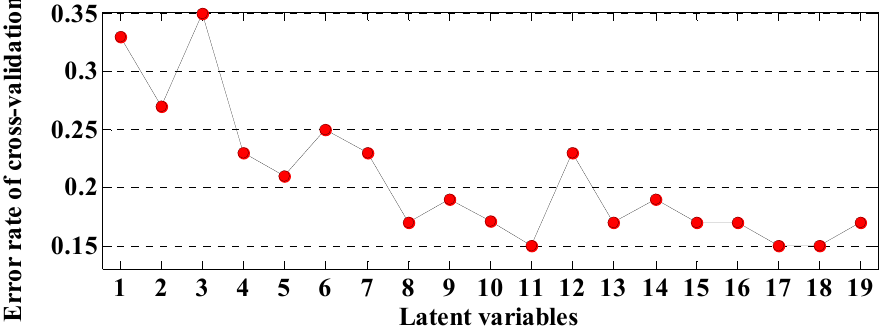
Figure 5. The optimal number of latent variables determination in the PLS-DA model.